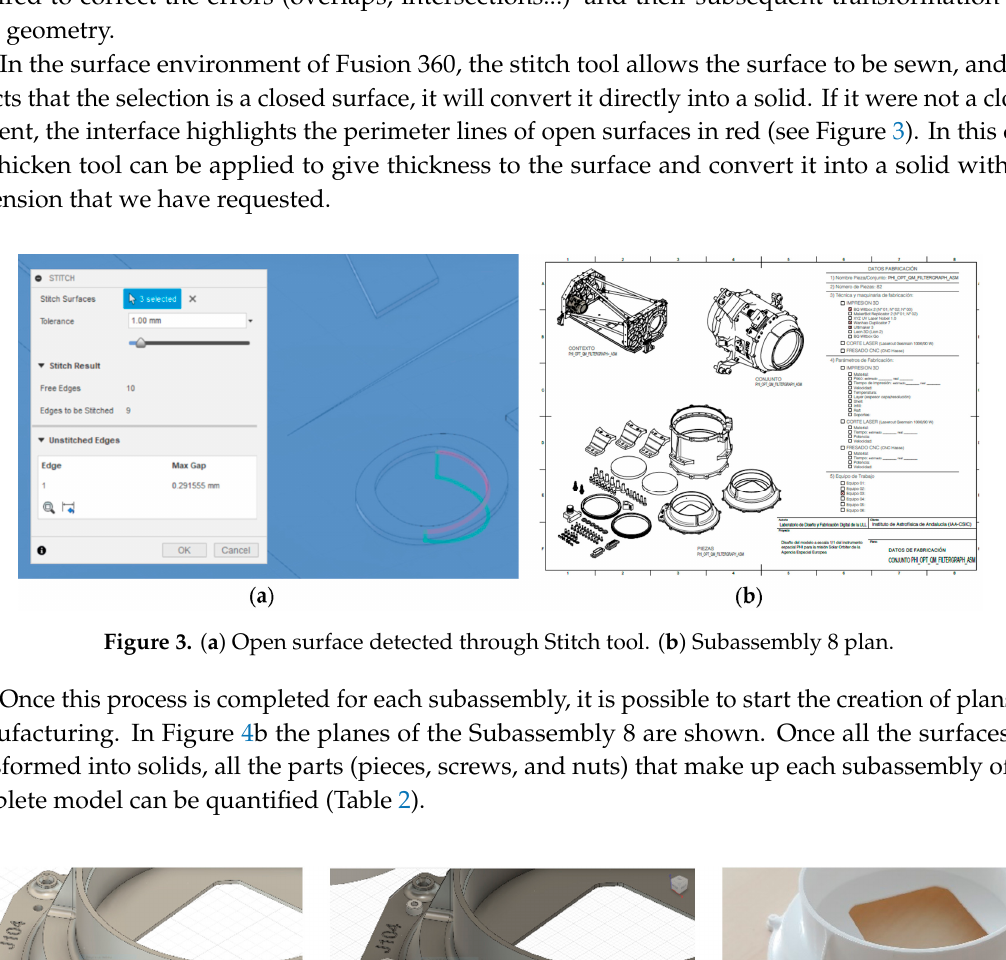
Table 2. Frequency analysis of pieces that integrate the SO/PHI subassemblies